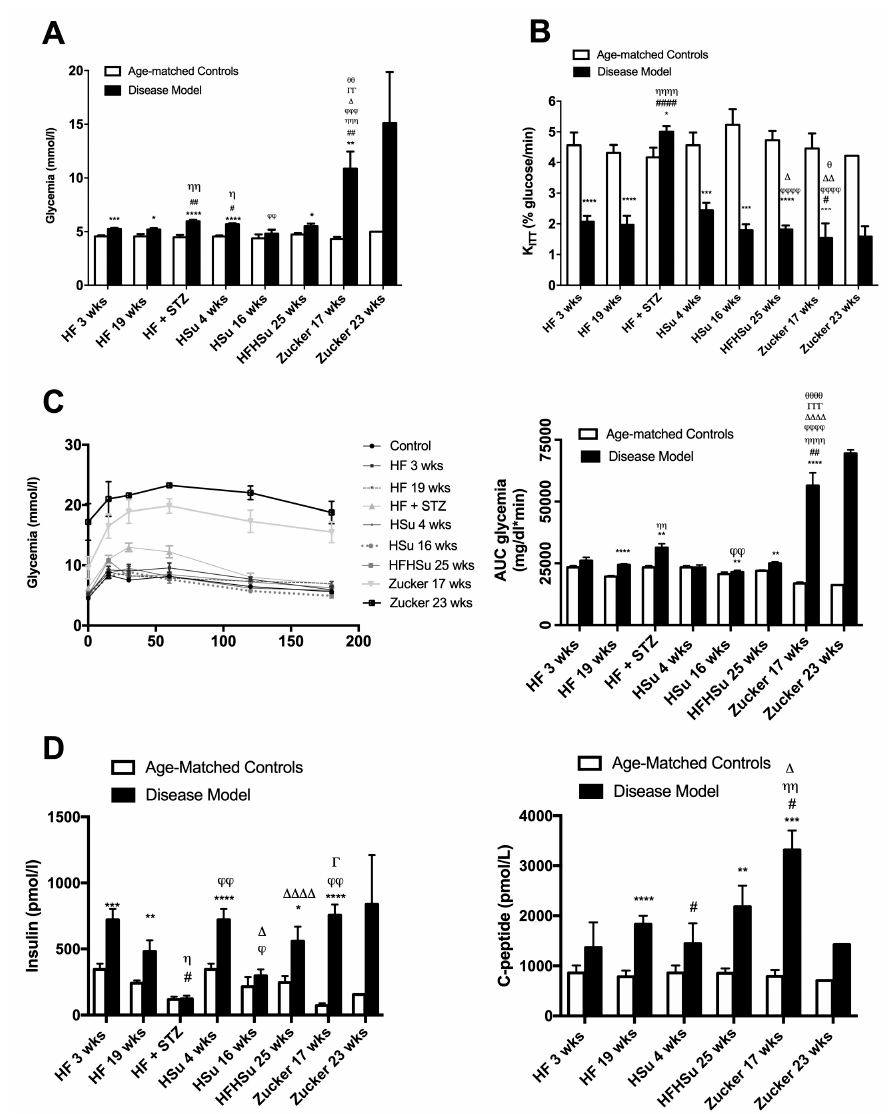
Figure 2. Glucose metabolism and insulin action and secretion in animal models of type 2 diabetes and obesity. ( A ) Fasting glycemia levels; ( B ) insulin sensitivity expressed as the constant of insulin tolerance test (K ITT ); ( C ) glucose tolerance depicted as glucose excursion curves ( left panel ) and as the area under the curve (AUC) obtained from the glucose excursion curves ( right panel ); ( D ) fasting insulin (left panel) and C-peptide (right panel) levels in animal models of obesity and type 2 diabetes. All groups of hypercaloric diet animals and its aged-matched controls as well as Zucker diabetic rat and its lean controls of 17 weeks included 6–8 animals per group; Zucker diabetic rat of 23 weeks included 3 animals per group, and its lean control only one animal. Bars represent means ± SEM; two-way ANOVA with Bonferroni’s multiple comparisons test: * p < 0.05, ** p < 0.01, *** p < 0.001, and **** p < 0.0001 comparing age-matched controls with disease models; # p < 0.05, ## p < 0.01, and #### p < 0.0001 comparing HF 3 weeks group with HF 19 weeks, HF + STZ, HSu 4 weeks, and Zucker 17 weeks; η p < 0.05, ηη p < 0.01, ηηη p < 0.001, and ηηηη p < 0.0001 comparing HF 19 weeks with HF + STZ, HSu 4 weeks, HFHSu 25 weeks, and Zucker 17 weeks; ϕ p < 0.05, ϕϕ p < 0.01, ϕϕϕ p < 0.001, and ϕϕϕϕ p < 0.0001 comparing HF + STZ with HSu 16 weeks, HFHSu 25 weeks, and Zucker 17 weeks; ∆ p < 0.05; ∆∆ p < 0.01, and ∆∆∆∆ p < 0.0001 comparing HSu 4 weeks with HFHSu 25 weeks and Zucker 17 weeks; Γ p < 0.05, ΓΓ p < 0.01, and ΓΓΓ p < 0.001 comparing HSu 16 weeks group with Zucker 17 weeks; θ p < 0.05, θθ p < 0.01, and θθθθ p < 0.0001 comparing HFHSu 25 weeks with Zucker 17